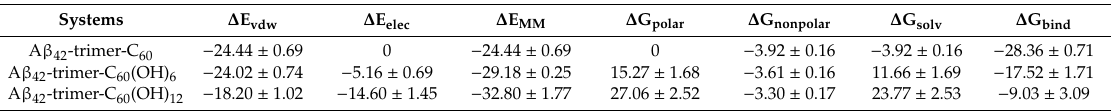
Table 1. Di ff erent components of binding free energy (in kcal / mol) between A β 42 -trimer and the fullerene / fullerenol